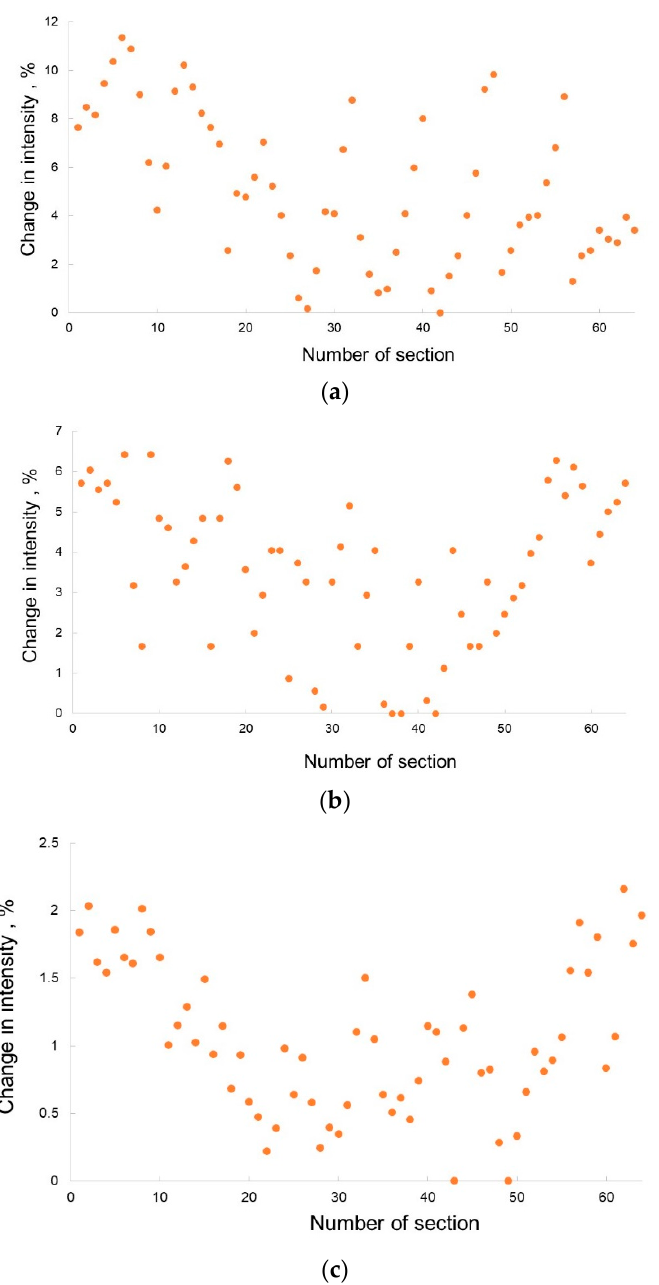
Figure 9. Graphs of the percentage change in intensity relative to the maximum value of the lumi- nescence emission obtained in the selected areas of the sample for different deposition methods: